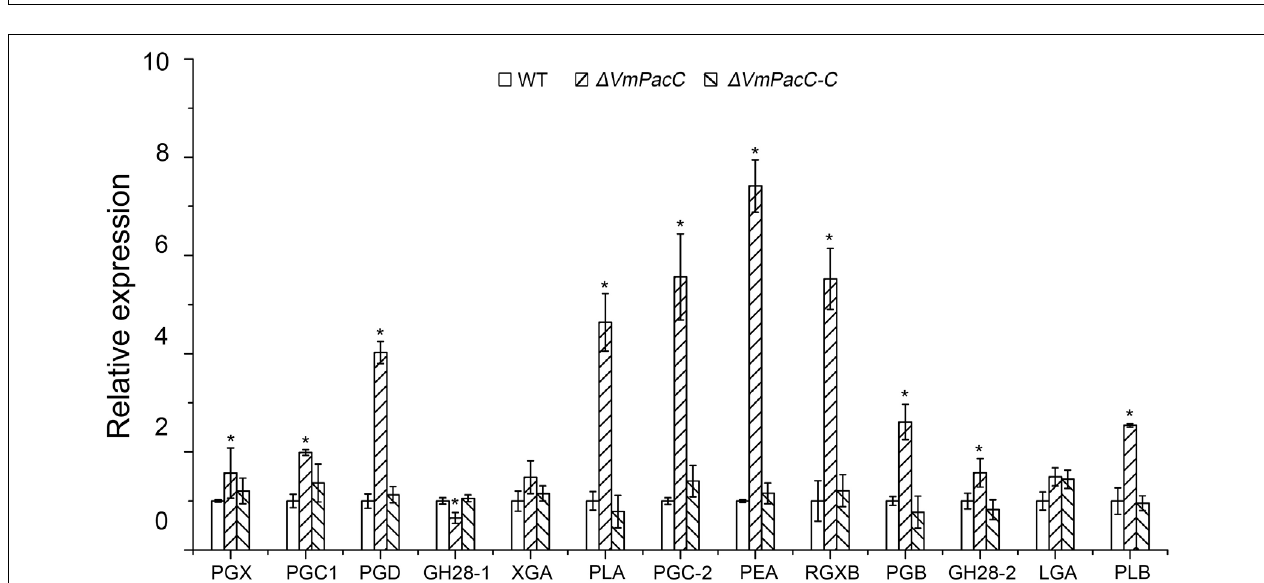
FIGURE 4 | Phenotype of leaves and twigs inoculated with VmPacC deleted mutants of V. mali . (A) Apple leaves were inoculated with mycelium agar plugs from the wild-type, deletion mutant, and complemented strains. Lesion sizes are shown at 3 days post-inoculation (dpi). (B) Apple twigs were scald inoculated with mycelium agar plugs from the wild-type, deletion mutant, and complemented mutant strains. Lesion sizes are shown at 9 dpi. (C) Quantitation of the lesion size on apple leaves is lesion diameter at 3 dpi. Quantitation of the lesion size on twigs is lesion length at 9 dpi. The asterisks represent a statistically significant difference compared to wild-type ( P < 0.05). Bars indicate standard deviations of the mean of three replicates.